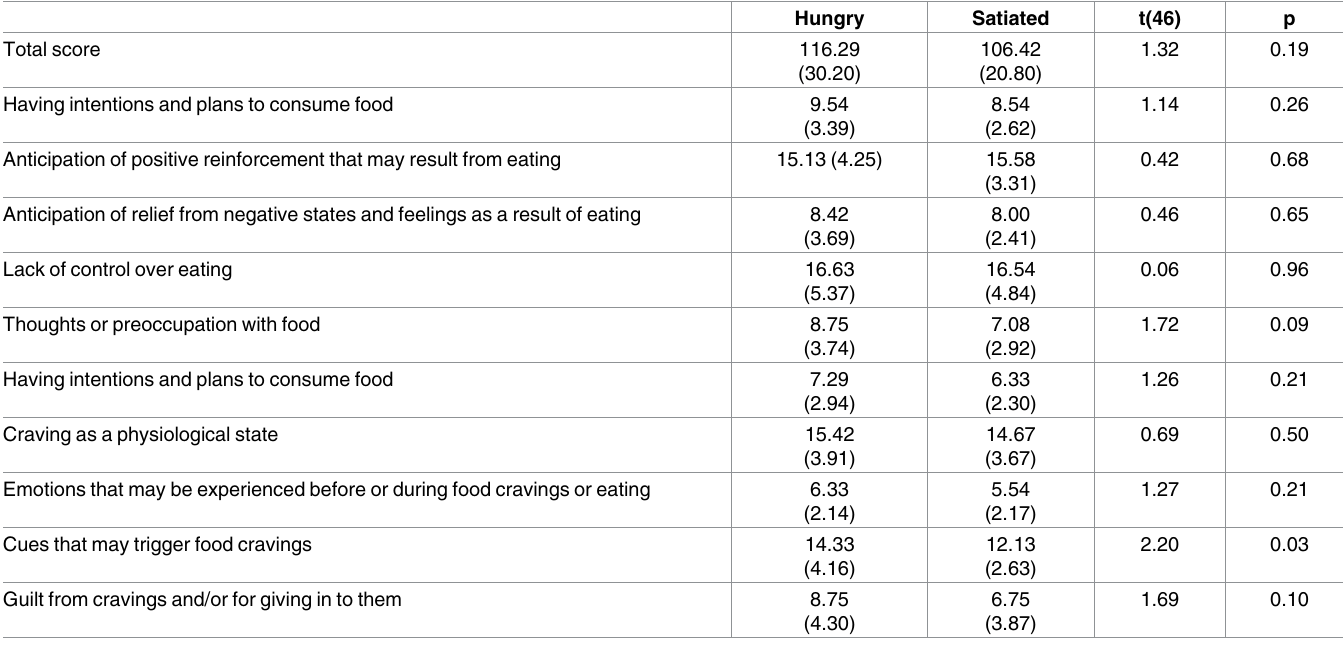
Table 2. Mean scores on the FCQ-T and its subscales for hungry and satiated participants, and corresponding statistical comparisons.